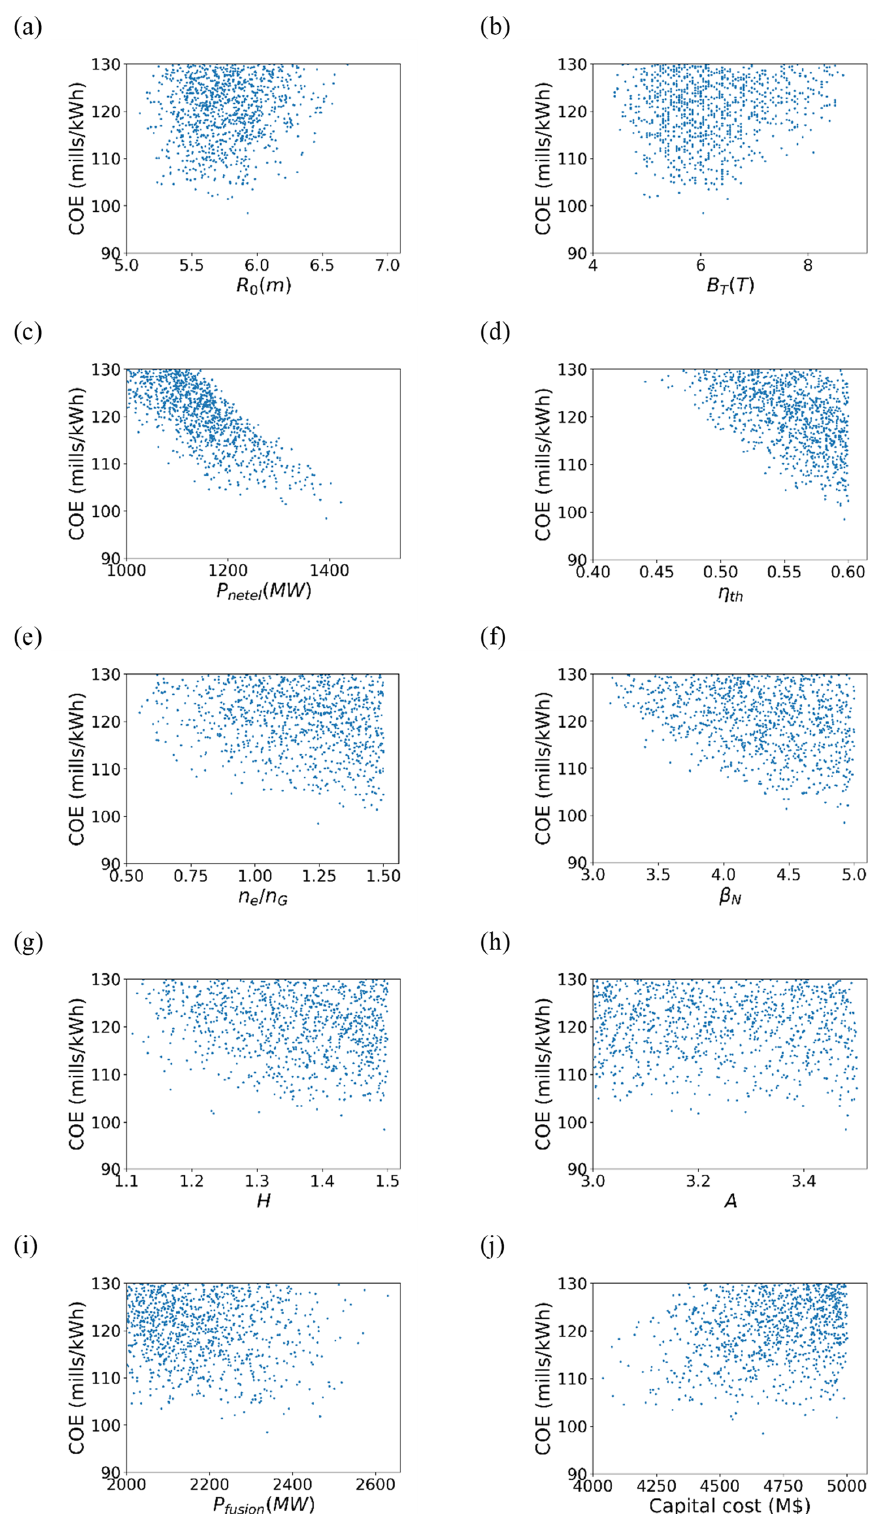
Figure 5. Variation of COE on ( a ) R 0 ; ( b ) B T ; ( c ) P e ; ( d ) η th ; ( e ) n e /n G ; ( f ) β N ; ( g ) H ; ( h ) A ; ( i ) P fusion , and ( j ) capital cost without the CS case.